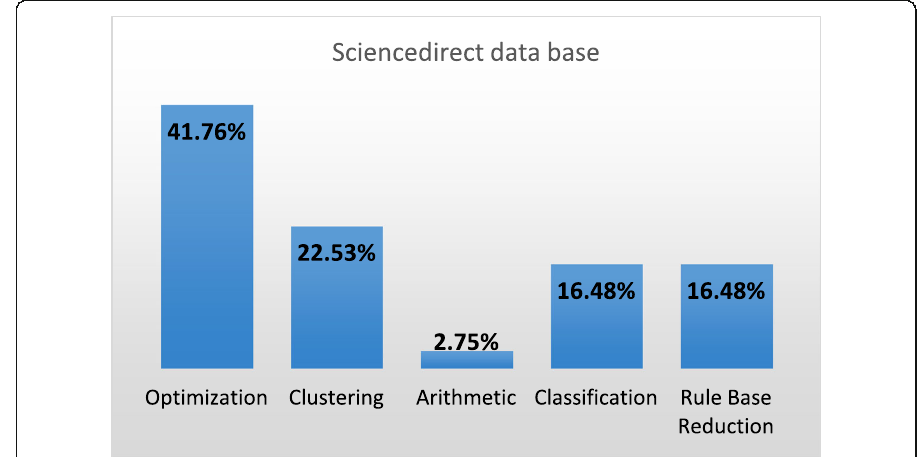
Fig. 10 ScienceDirect fuzzy tool